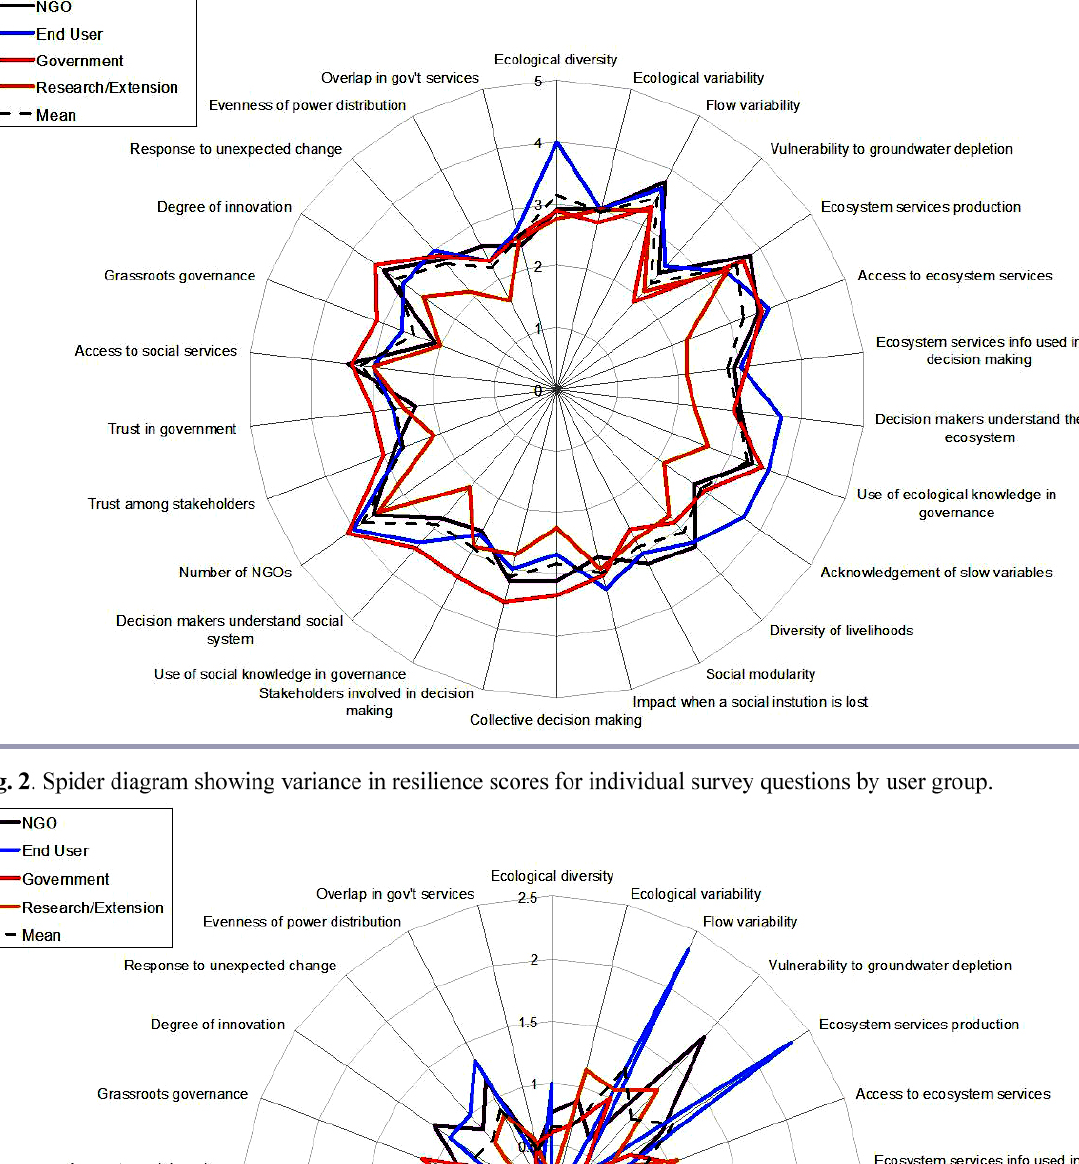
Fig. 1 . Spider diagram showing average resilience scores for individual survey questions by user